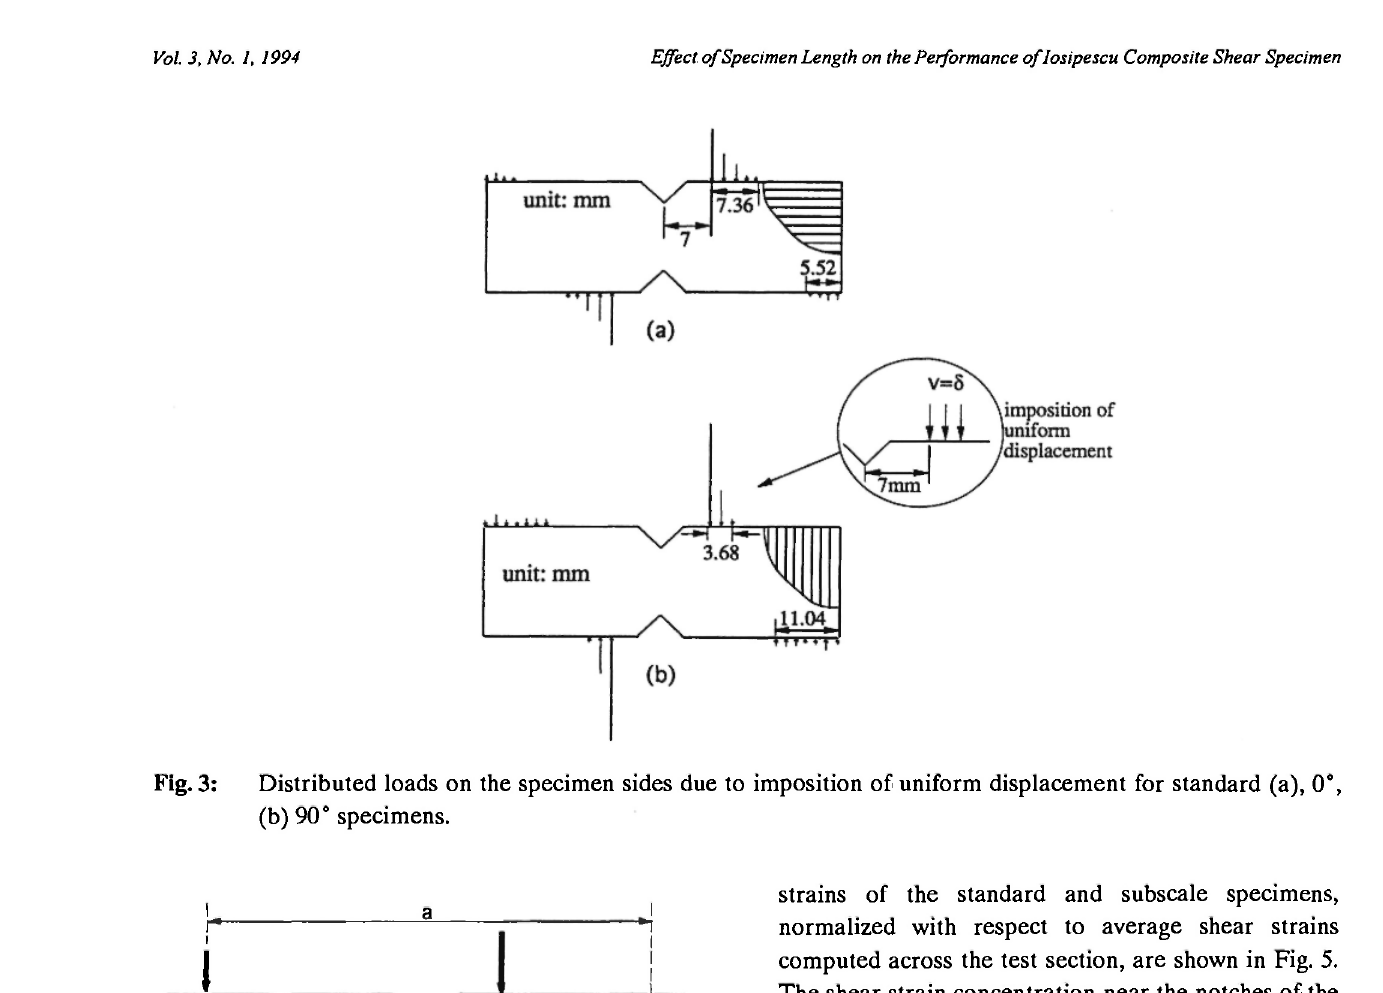
Fig. 3: Distributed loads on the specimen sides due to imposition of uniform displacement for standard (a), 0°, (b) 90° specimens.